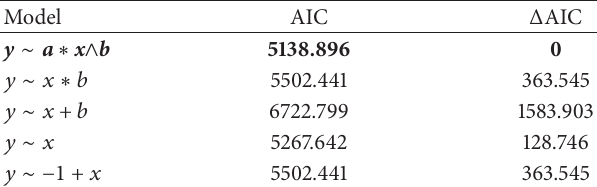
Table 2: Results of models analyses (AIC = Akaike Information Criterion; Δ 𝑖 ( AIC ) = AIC 𝑖 − minAIC )